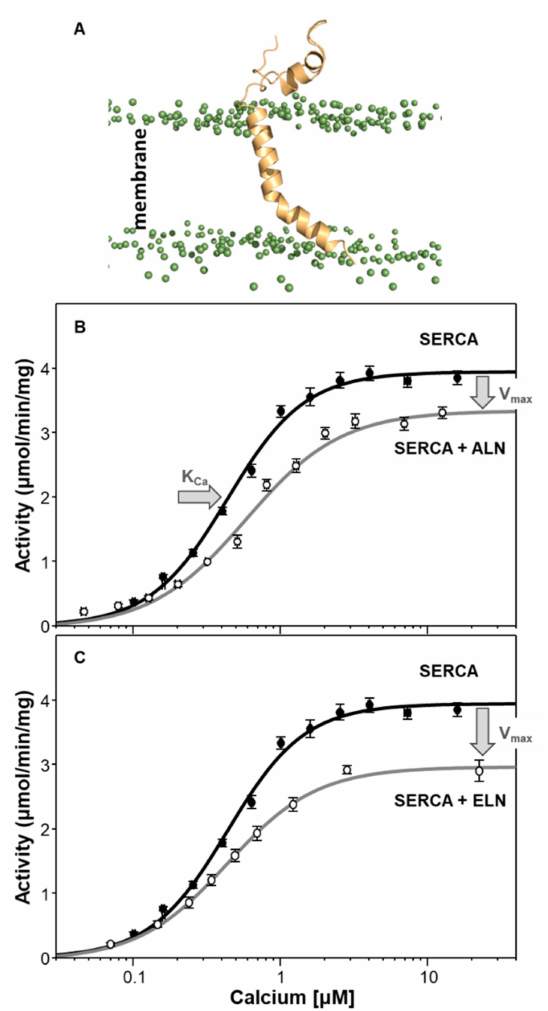
Figure 7. SERCA, another-regulin (ALN) and endoregulin (ELN). ( A ) Molecular model after molecu- lar dynamics simulation of ALN in a lipid bilayer. The headgroups of the phospholipids are indicated as green spheres. The cytoplasmic domain of ALN (residues 1–38) is largely unstructured and lies along the membrane surface. The transmembrane domain of ALN is kinked and slightly longer than predicted (residues 39–65). ( B ) Calcium-dependent ATPase activity of SERCA reconstituted into membrane vesicles in the absence (black) and presence of ALN (gray). The change in the apparent calcium affinity (K Ca ) and maximal activity (V max ) of SERCA is indicated by arrows. ( C ) Calcium-dependent ATPase activity of SERCA reconstituted into membrane vesicles in the absence (black) and presence of ELN (gray). The change in the maximal activity (V max ) of SERCA is indicated by an arrow. Each data point is the mean ± standard error ( n ≥